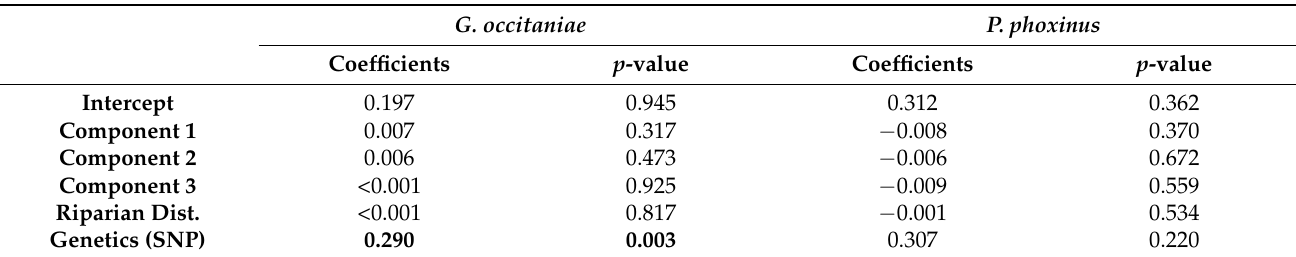
Table 5. Summary of multiple regression on distance matrices (MRM) testing the relationships between epigenetic differentiation, genetic differentiation (based on SNP markers), environmental (PCA components 1 to 3), and geographical (riparian) distances between sites in G. occitaniae and P. phoxinus . Parameters associated to each explanatory variable are shown, together with their p –values (1000 permutations). Significant relationships are